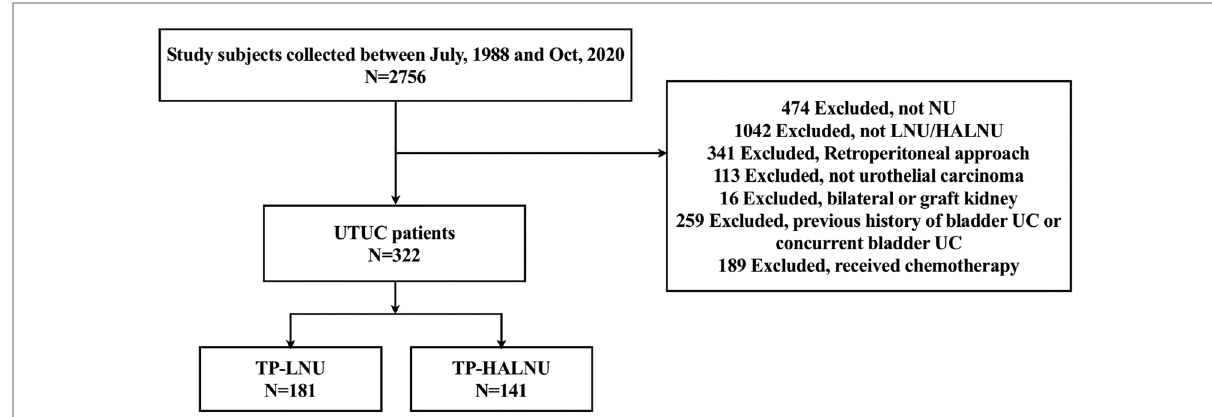
FIGURE 1 Study fl owchart. UTC, upper tract urothelial carcinoma; UC, urothelial carcinoma; NU, nephroureterectomy; LNU, laparoscopic nephroureterectomy; HALNU, hand-assisted laparoscopic nephroureterectomy; TP-LNU, transperitoneal laparoscopic nephroureterectomy; TP- HALNU, transperitoneal hand-assisted laparoscopic